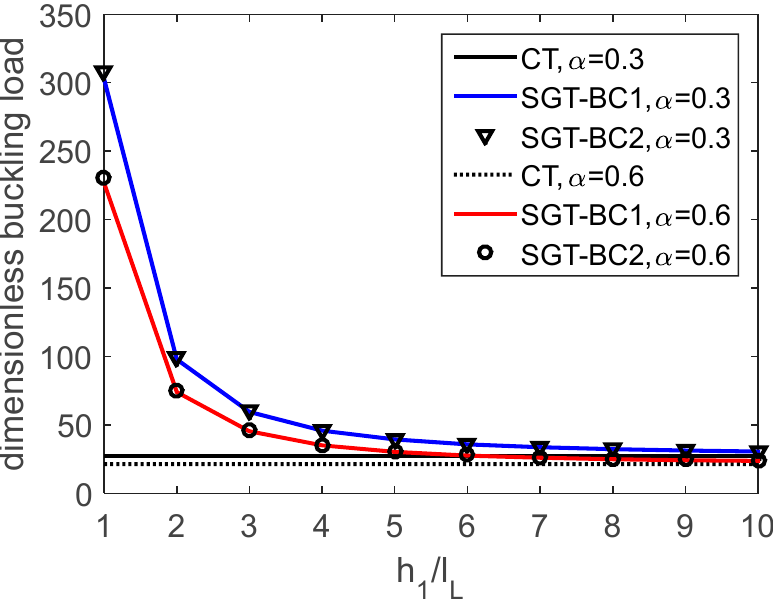
Figure 3. Variation of dimensionless buckling load for propped cantilever microbeams with respect to h 1 /l L for different taper ratios ( 𝑛 = 2 ).